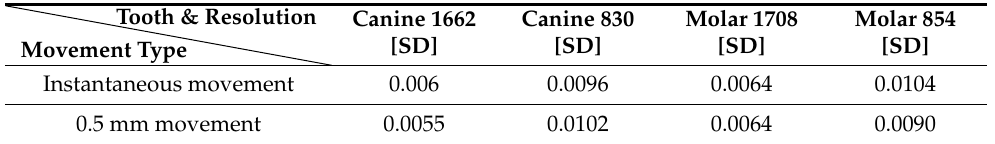
Table 4. The 95% confidence level (1.96) standard deviation of the produced Bland–Altman plots for lower resolutions. The benchmark resolutions are 26,608 facets for Canines and 29,103 for Molars.